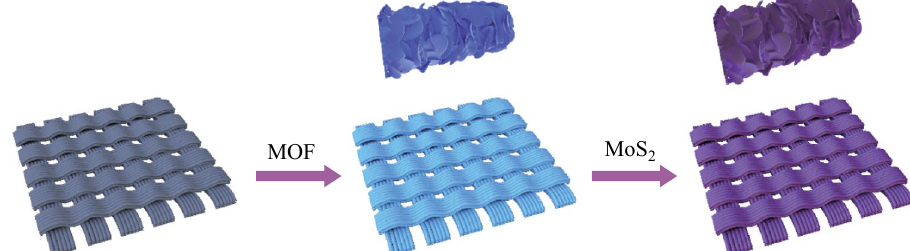
Fig. 1 Schematic illustration of MOS/COS/CC electrocatalyst synthesis